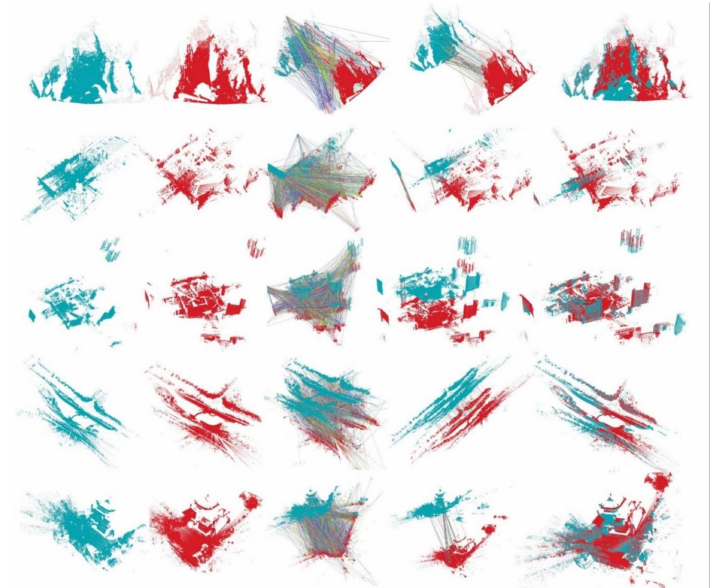
Figure 12. Sample visual registration results by our PPTFH descriptor on the WHU-TLS dataset. From left to right: model point cloud (dark green color); scene point cloud (red color); correspondences by PPTFH+NNSR technology; correspondences by GC technology; and the registration results by RANSAC